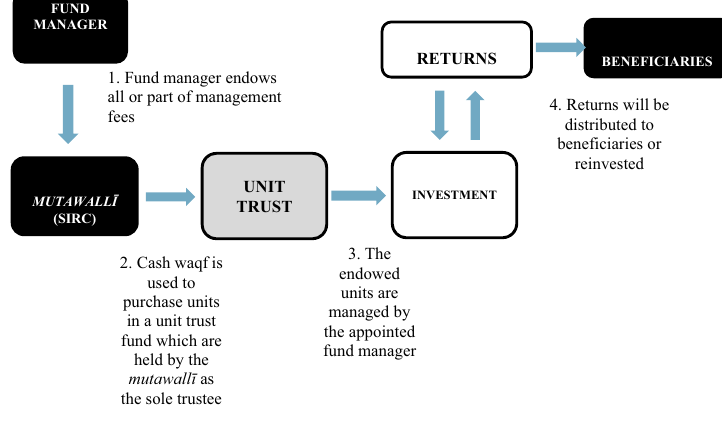
Figure 6. Fifth proposed model: waqf of the management